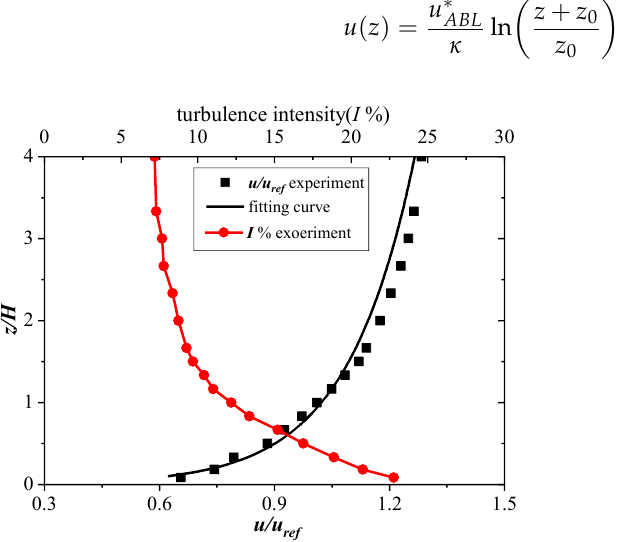
Figure 4. The profiles of streamwise mean velocity and turbulence intensity at the inlet boundary.